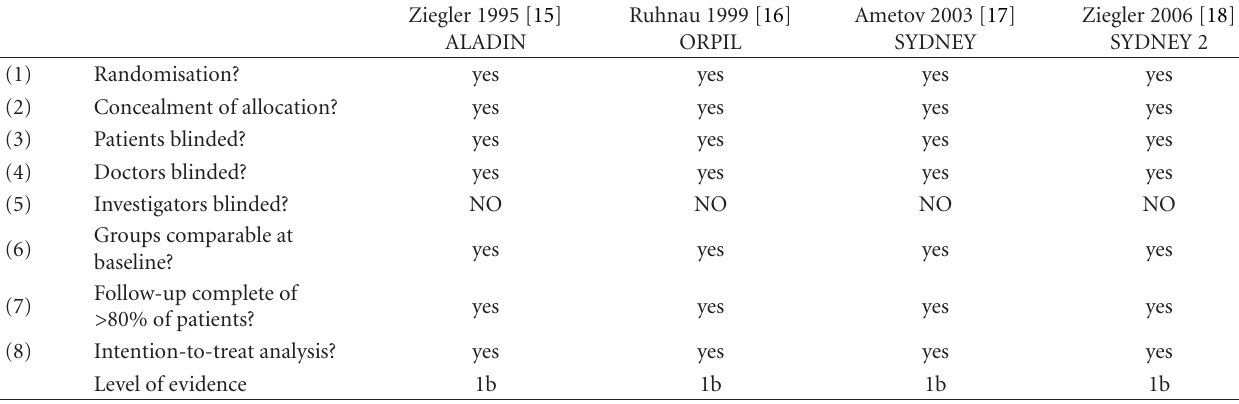
Table 1: Methodological quality assessment of the included intervention